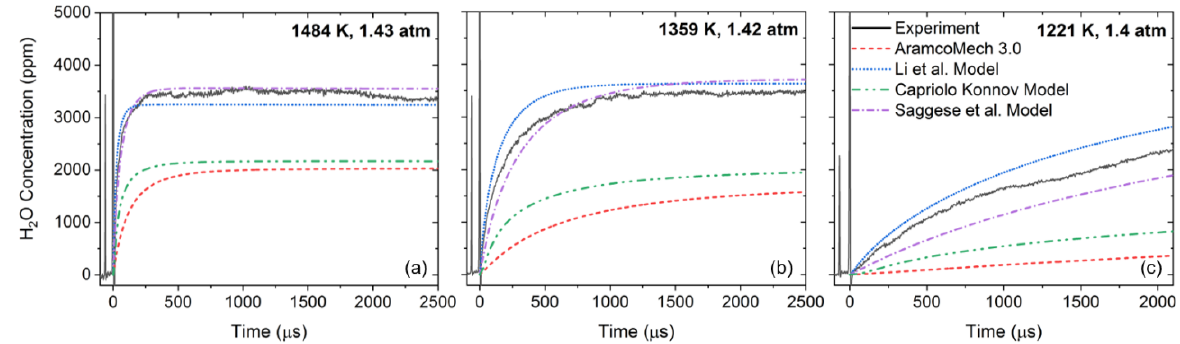
Figure 2. Experimental H 2 O time histories isopropanol pyrolysis (Mix 1) for three temperatures (( a ) 1484 K, ( b ) 1359 K, and ( c ) 1221 K) near 1.4 atm compared to four model predictions.